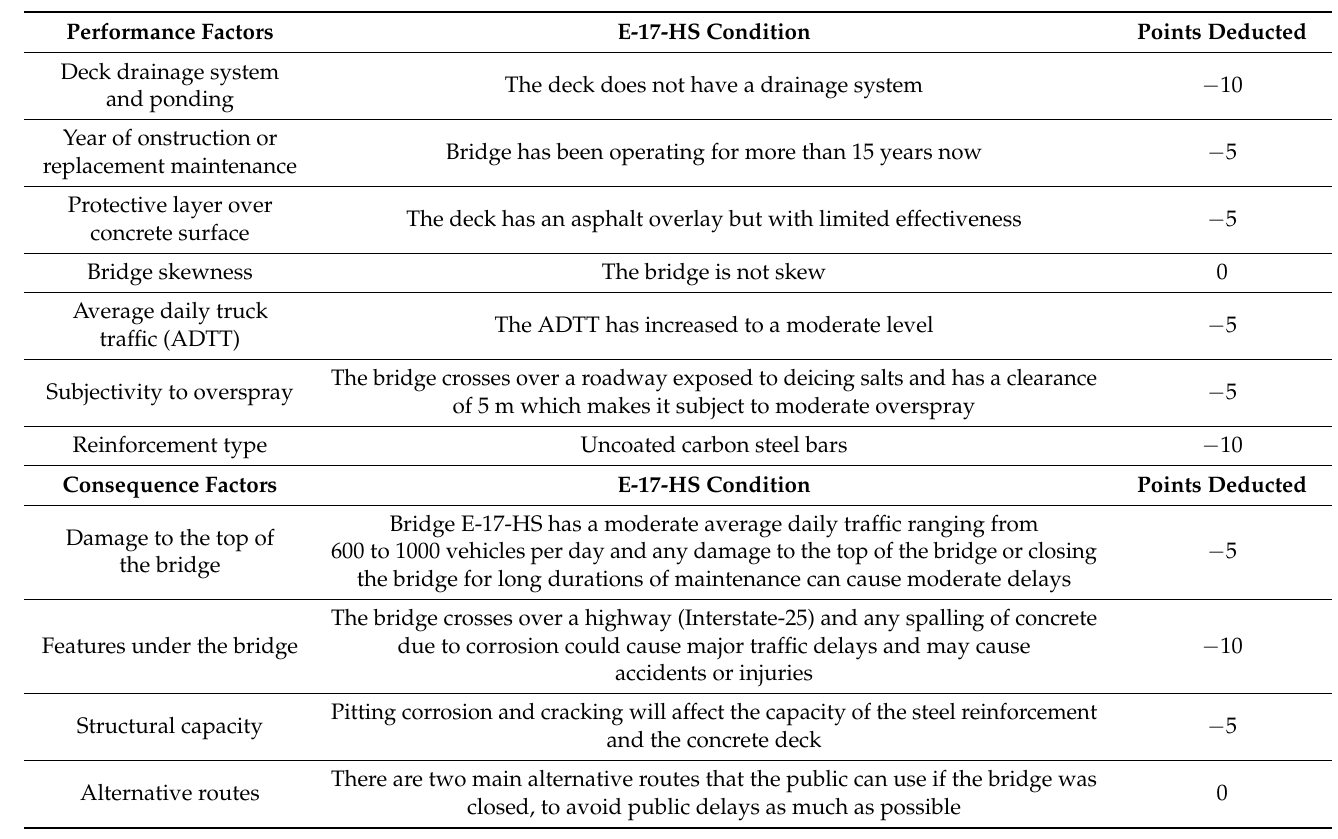
Table 14. Points that will be deducted based on the P&C